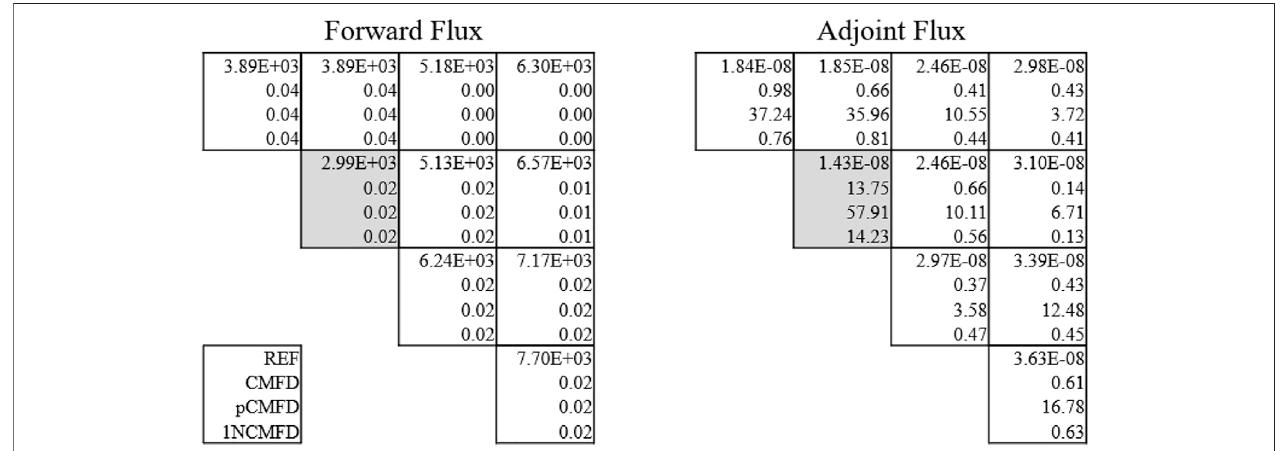
FIGURE 7 | Percentage error for forward and adjoint fl uxes with a node size of 10 cm.